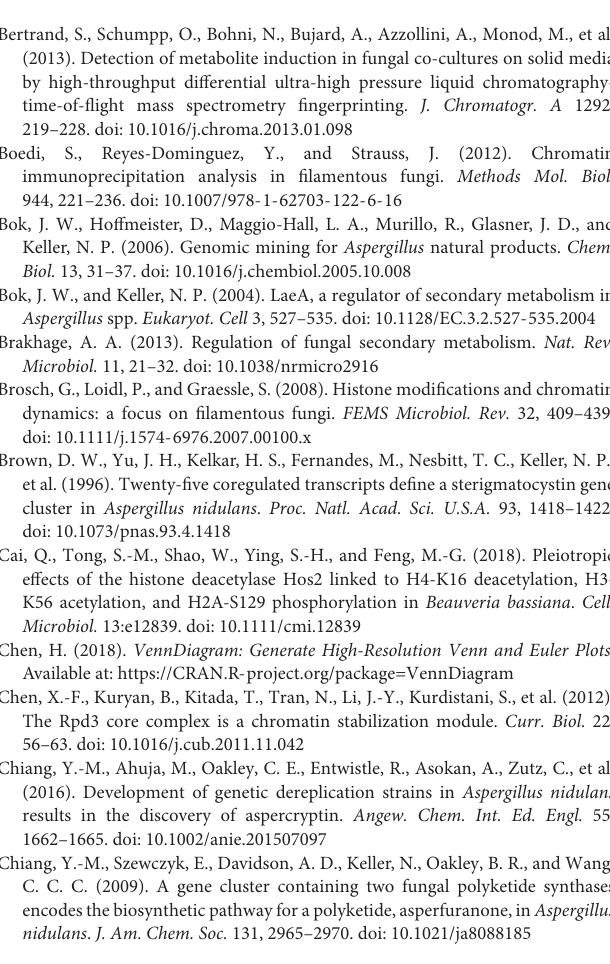
levels in wildtype and hosA mutants after 24 and 60 h of growth are compared (data sheet 2). Expression confirmed by Northern blot experiments are highlighted in gray. TABLE S6 | Selected Cuffdiff results of the orsellinic acid, aspercryptin, cichorine and penicillin gene clusters of hosA mutants grown for 24 and 60 h compared to wildtype. Secondary metabolite gene clusters (gray) flanked by five up- and five downstream genes are shown to confirm the specific regulation of the SM clusters. Sample 1 is compared to sample 2 including the corresponding FPKM value for both samples, the resulting log2fc, the fold change and the p -value. TABLE S7 | Confirmed or putative secondary metabolite gene clusters and adjacent genes. (Predicted) key enzymes such as polyketide synthases or non-ribosomal peptide synthetases of the respective SM clusters are highlighted in the data sheets in gray. Expression levels of the key synthases and at least 20 adjacent genes flanking both sides of each key enzymes were compared between wildtype and hosA mutants of short-term (24 h) and long-term (60 h) cultures. Relating to the log2FC, a cutoff of ± 1.0 was applied considering the significance criteria (sig) of Cuffdiff. TABLE S8 | Results of FungiFun2 analysis performed with the FunCat classification ontology option. Genes listed in Supplementary Table S4 were used as input IDs. For each comparison between wildtype and hosA mutant strains grown for 24 and 60 h, genes were divided into up- and downregulated categories. Category and gene-ID summary containing gene-ID, protein name, FunCat ID with description, and p -values are